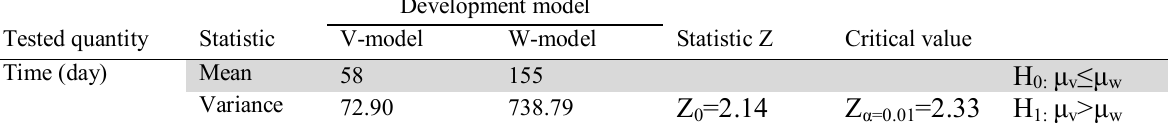
Results of design and construction time of prototypes using V-model and W-model.